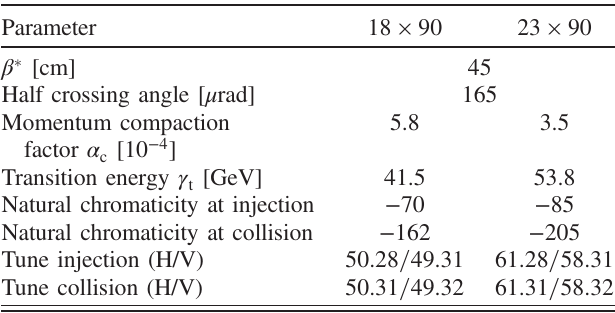
TABLE IV. Lattice parameters of the HE-LHC baseline